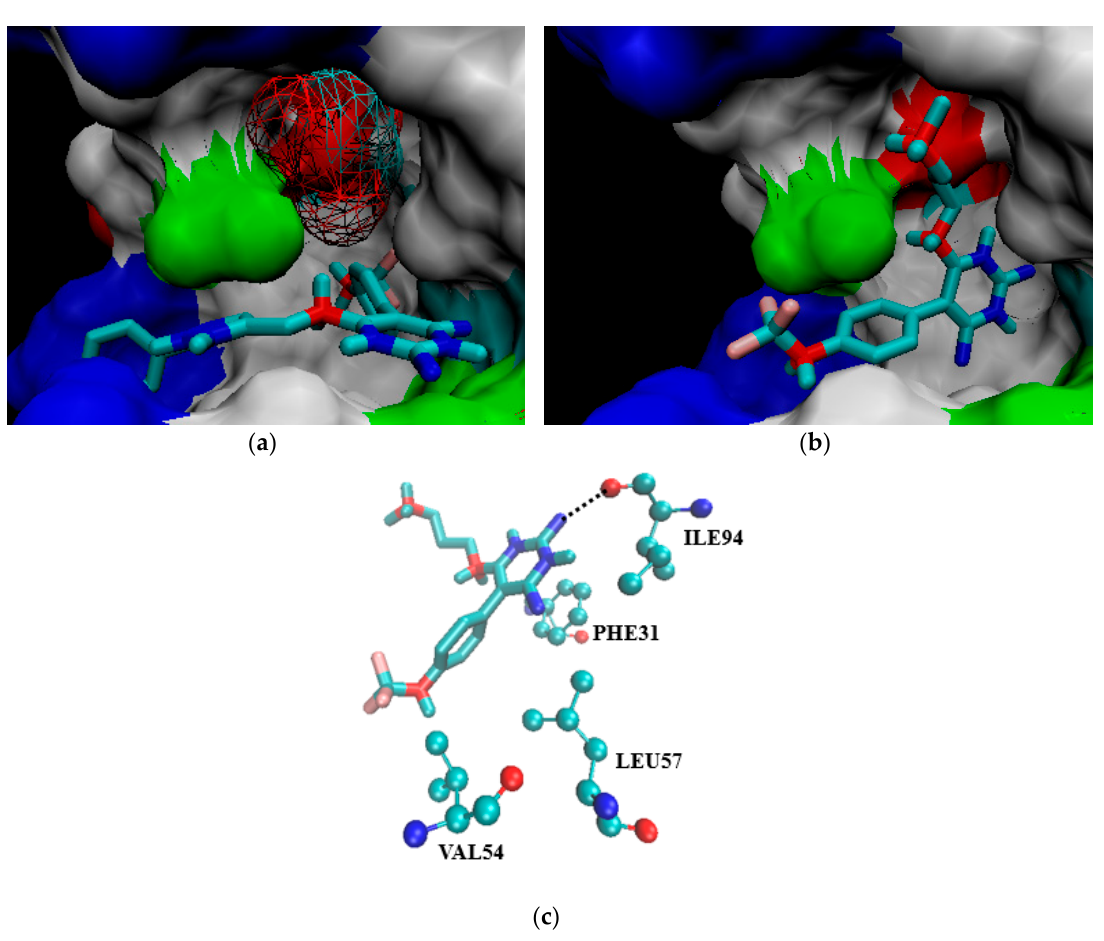
Table 3. Binding free energies (Kcal/mol) of compound 16l in mt -DHFR.